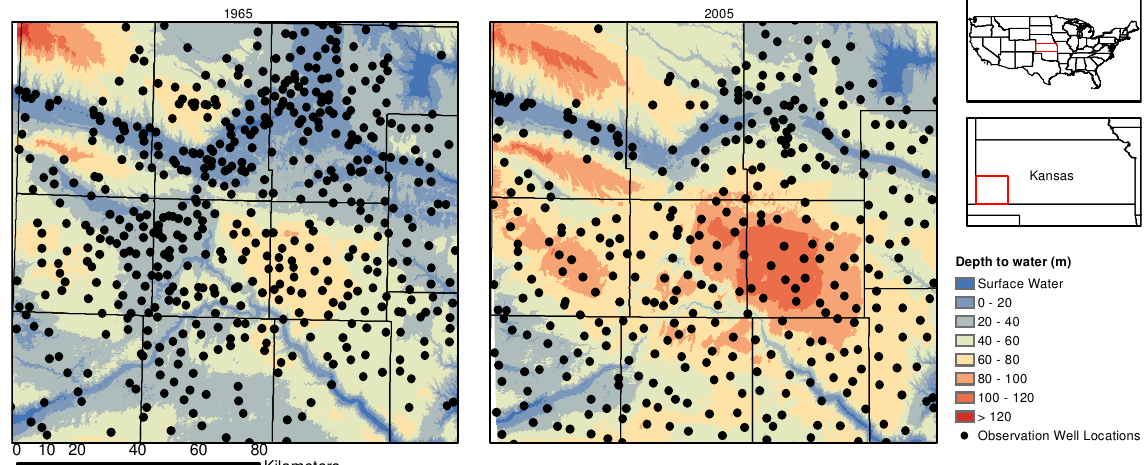
Fig. 1. The study region in southwestern Kansas and depth to water in 1965 and 2005, years for which aerial photography is available.